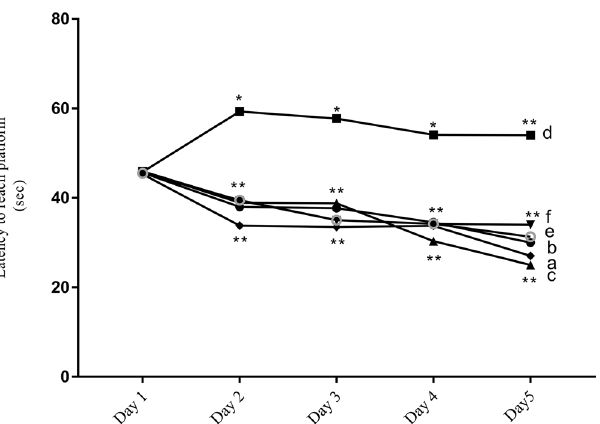
Figure 3. Morris water maze results of all experimental groups following TBI. Short-term defects in spatial learning were detected in the TBI group. Saffron and crocin enhanced the induced cognitive deficits and both groups showed no difference in their latency to reach the platform a: sham, b: saffron sham, c: crocin sham, d: TBI, e: saffron TBI, f: crocin TBI. Data are mean of eight mice per group. (*) and (**) represent p < 0.03 and < 0.0021